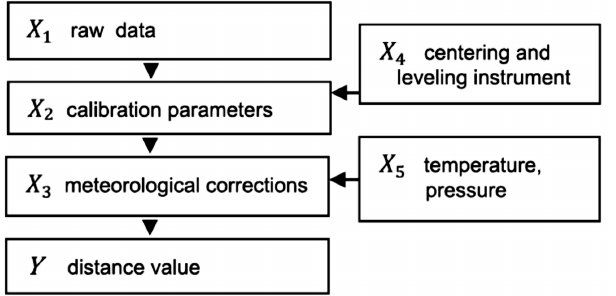
Figure 3. Influence factors for electronic distance measurements: processing steps for the derivation of an input quantity for an adjustment, from [11].